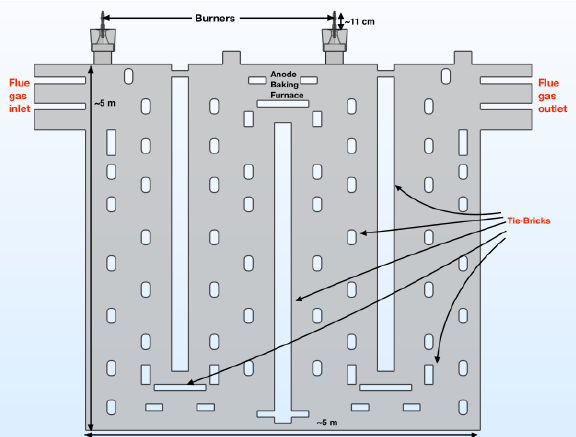
Figure 2. Schematic view of single section of the anode baking furnace with air inlet (located at the top left of the furnace section), two burners (mounted at the top of the section) and outlet (located at the top right of the